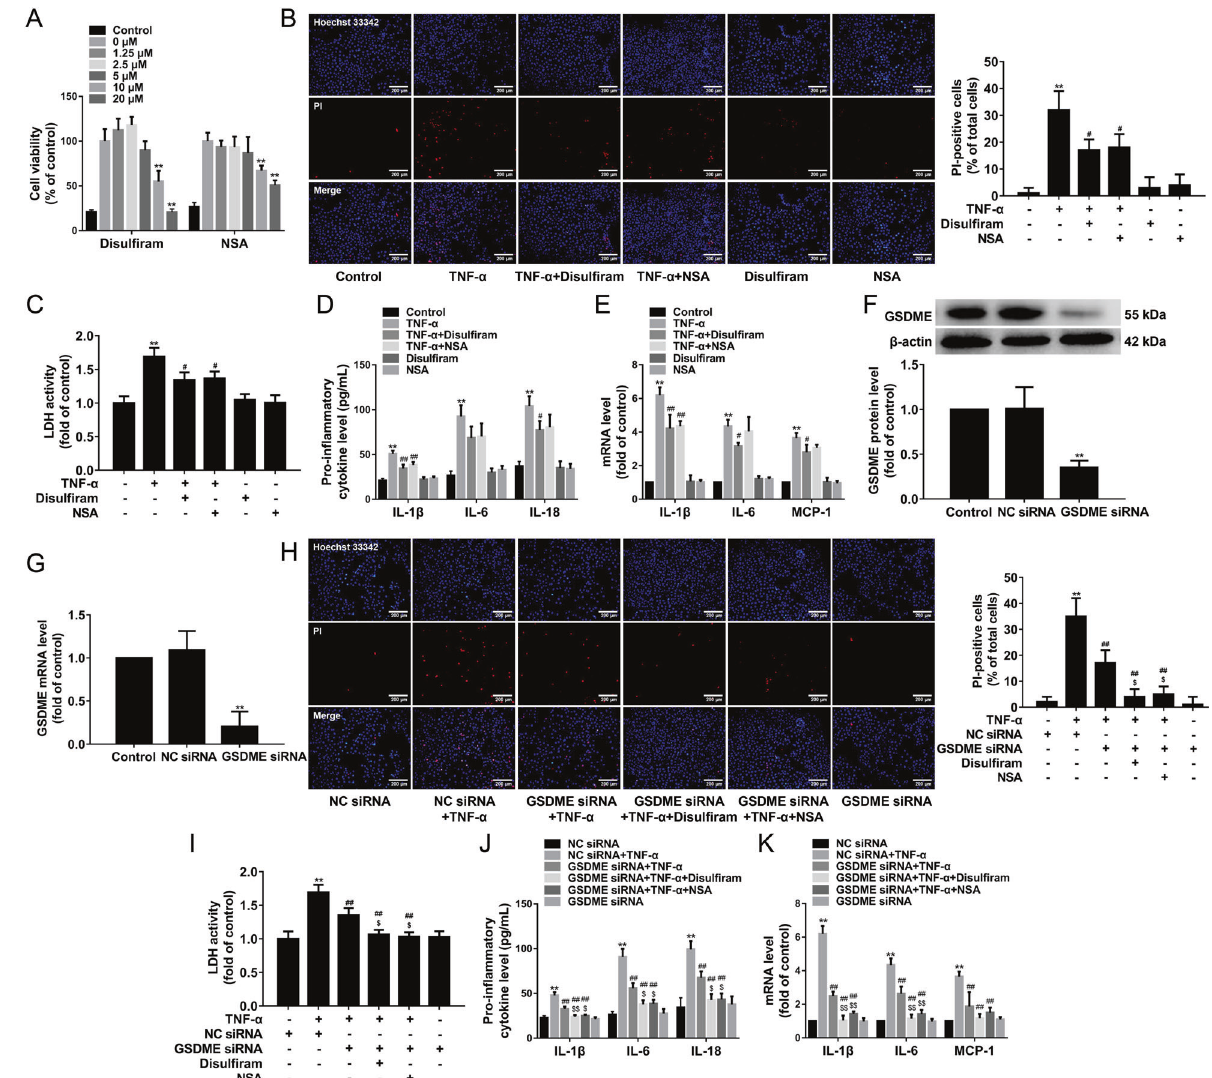
Fig. 6 GSDMD inhibitors and GSDME knockdown inhibit pyroptosis and in fl ammatory response in TNF- α -induced HUVECs. A HUVECs were treated with different concentrations of disul fi ram and NSA (1.25, 2.5, 5, 10, or 20 μ mol/L) for 13 h.The cell viability was evaluated by MTT assay ( n = 6). B HUVECs were pretreated with disul fi ram or NSA (5 μ mol/L) for 1 h and then stimulated with TNF- α for 12 h. The representative photographs of double- fl uorescent staining with PI (red) and Hoechst 33342 (blue), and the quanti fi cation of PI-positive cells, ×100. Scale bar indicates 200 μ m. C The cellular supernatant LDH level was evaluated with a cytotoxicity detection LDH kit. D The levels of IL-1 β , IL-6, and IL-18 in the cellular supernatant were detected by ELISA assay. E The mRNA expressions of IL-1 β , IL-6, and MCP-1 were determined by